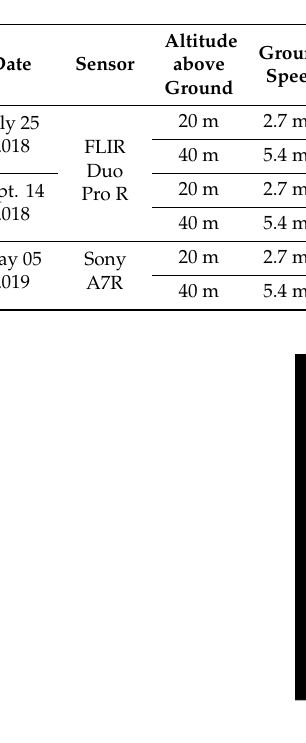
Table 3. FLIR and Sony flight parameters for the di ff erent data acquisition dates.